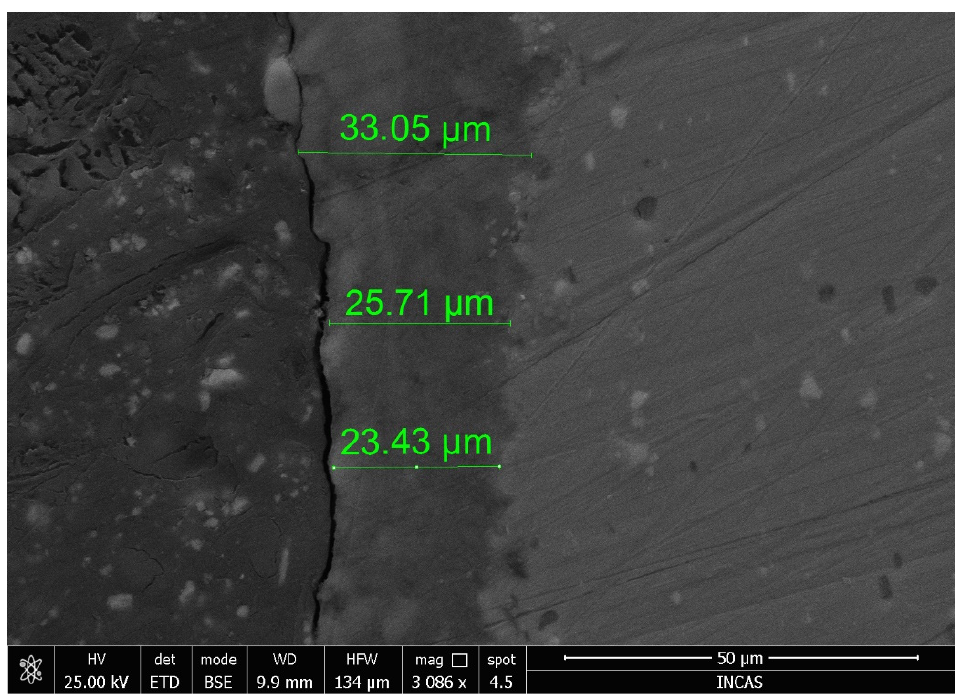
Figure 10. SEM micrograph of the cross section of the sample after testing.